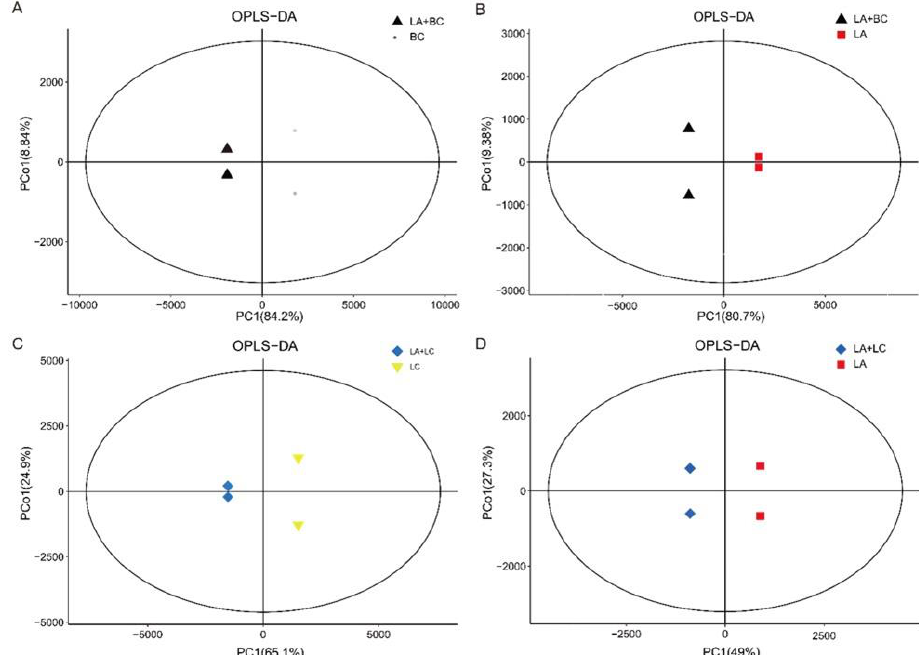
Figure 4. Orthogonal partial least-squares discrimination analysis (OPLS-DA) of different microbial culture metabolites. ( A ); L. antibioticus 13-6 and B. cereus BT-23 co-culture (LA+BC) vs. B. cereus BT-23 (BC). ( B ); L. antibioticus 13-6 and B. cereus BT-23 co-culture (LA+BC) vs. L. antibioticus 13-6 (LA). ( C ); L. antibioticus 13-6 and L. capsici ZST1-2 co-culture (LA+LC) vs. L. capsici ZST1-2 (LC). ( D ); L. antibioticus 13-6 and L. capsici ZST1-2 co-culture (LA+LC) vs. L. antibioticus 13-6 (LA).